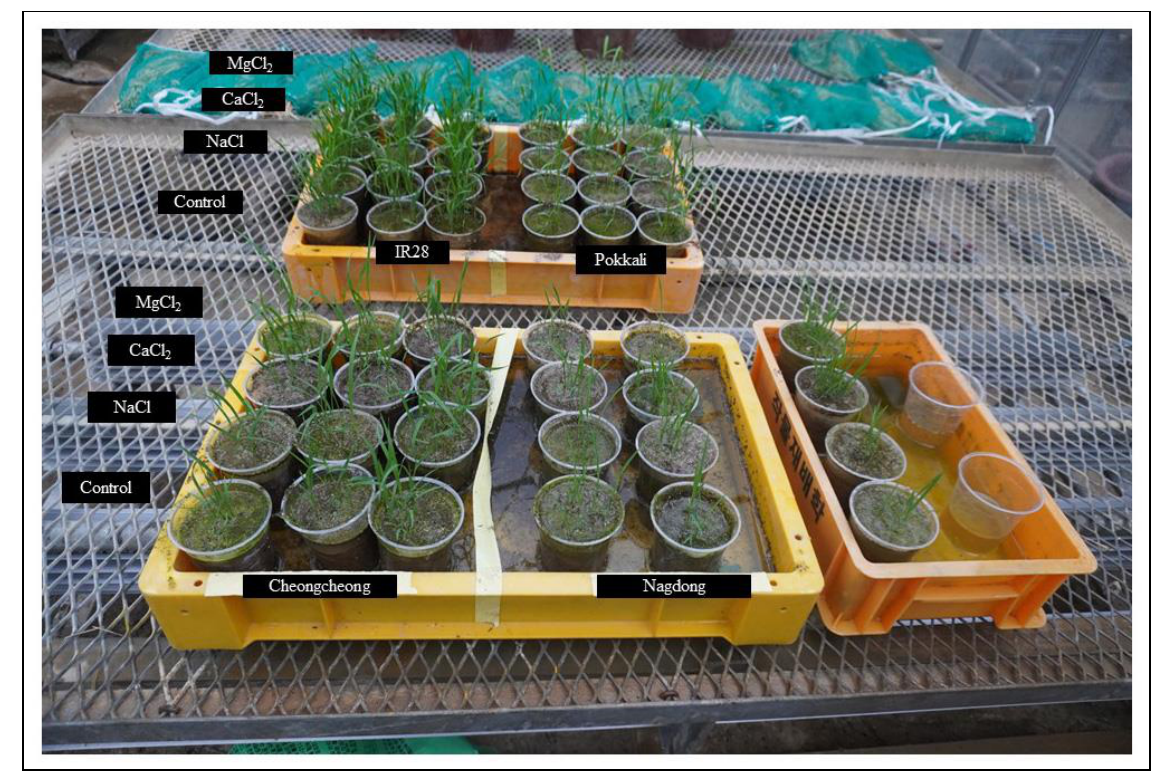
Figure 1. Rice seedlings growing in a greenhouse. After 14 days, treatment with 150 mM of different salt types was applied for 24 h.